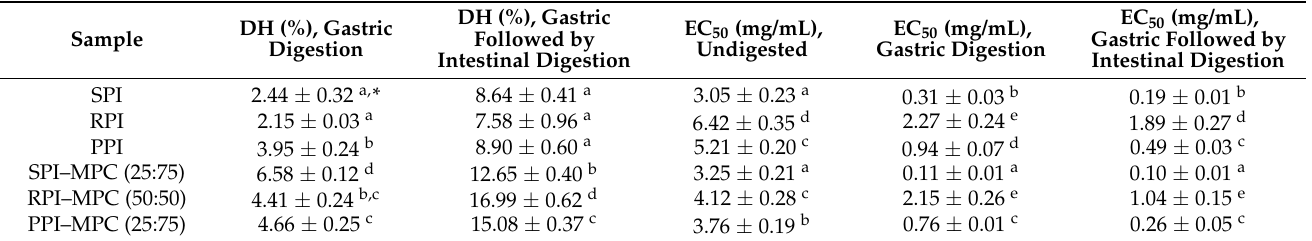
Table 2. Degree of hydrolysis and azinobis ethylbenzothiazoline sulfonic acid radical scavenging activity of the soy, rice and pea protein isolates and their associated blends with milk protein concentrate after digestion with pepsin (gastric phase) followed by Corolase PP (intestinal